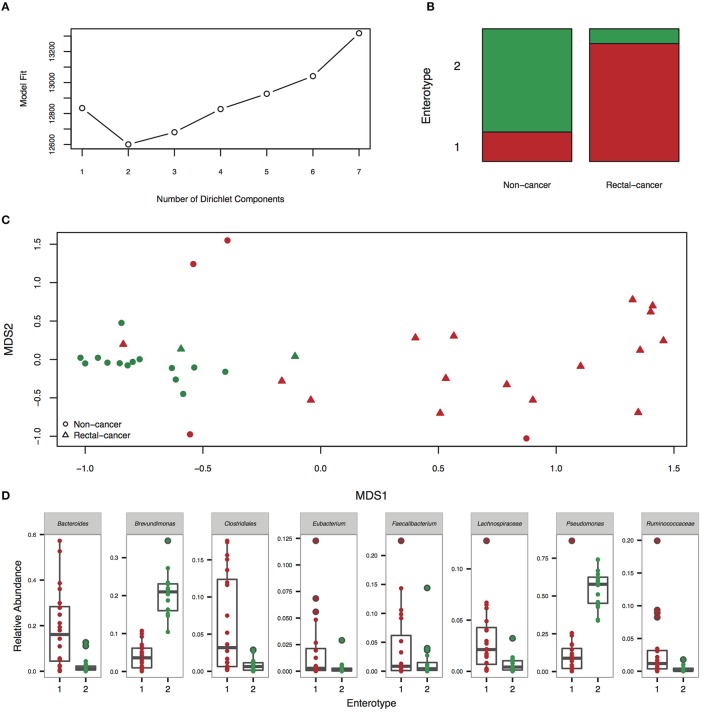
Enterotyping analysis reveals the presence of two community types. (A) Fitting to the Dirichlet Multinomial Mixture model indicates optimal classification into two community types. (B) Distribution of rectal-cancer samples and non-cancer samples in both enterotypes (P = 0.0001, Fisher's exact test). (C) Non-metric dimensional scaling (NMDS) ordination plot of Jensen–Shannon divergence values between samples. Red, community type-1; green, community type-2. (D) Relative abundances of the top 8 most abundant genera in the two community types.